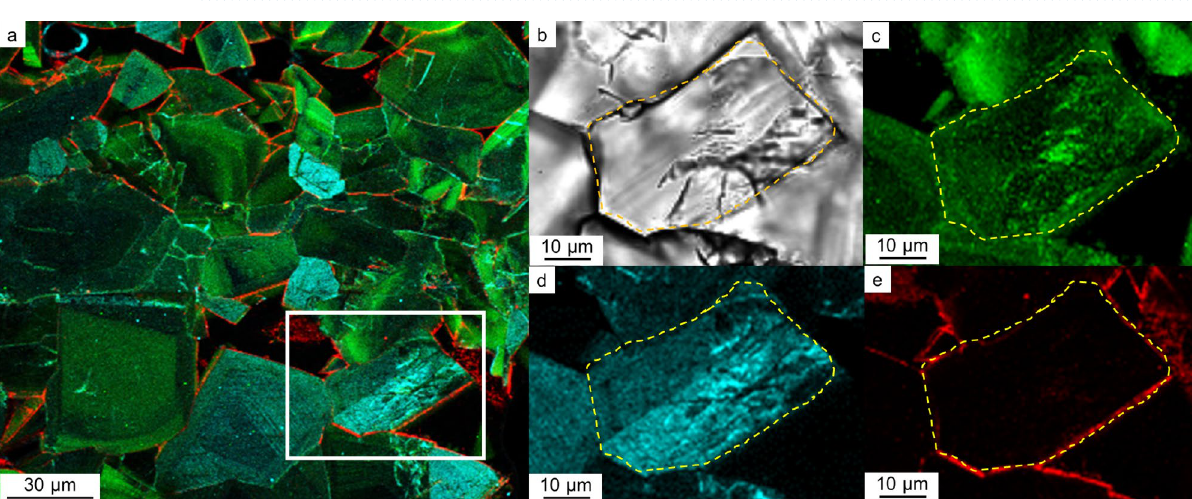
Figure 3. Protein distributions in a mosaic COM. ( a ) Multi-IF image. Enlarged images of the white box area are shown in ( b )–( e ). ( b ) Optical image. A grain boundary is shown with a yellow dashed line. ( c ) IF image of OPN. A grain boundary is shown with a yellow dashed line. ( d ) IF image of RPTF-1. A grain boundary is shown with a yellow dashed line. ( e ) IF image. A grain boundary is shown with a yellow dashed